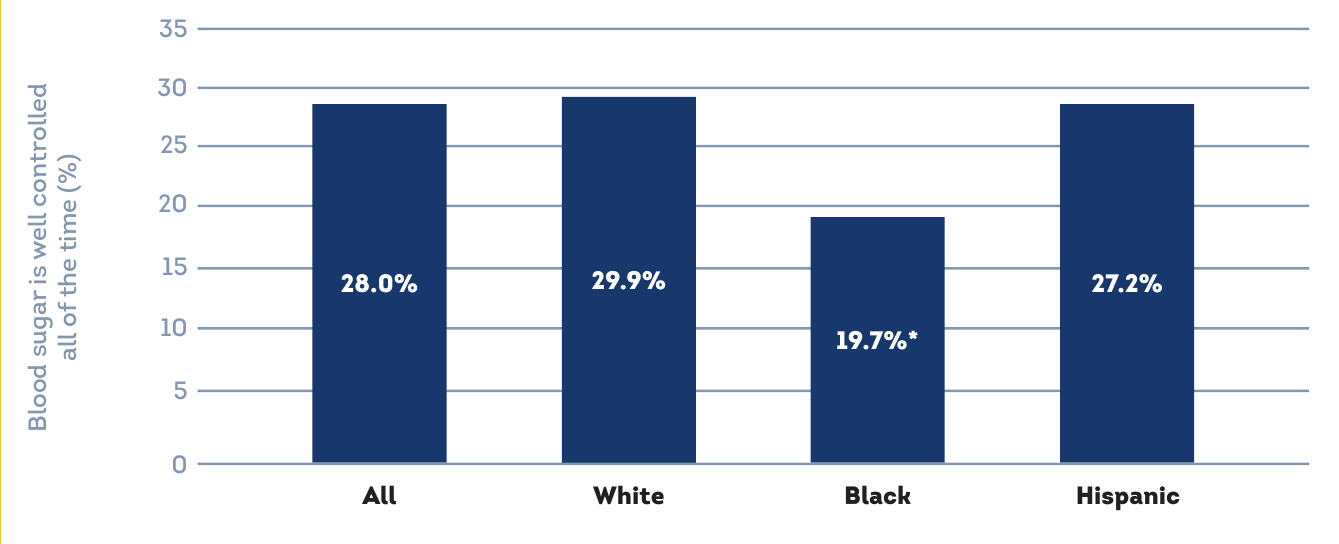
Figure 7. Percentage reporting that their blood sugar is well controlled all of the time, among community-dwelling Medicare beneficiaries with diagnosed diabetes, by race/ethnicity